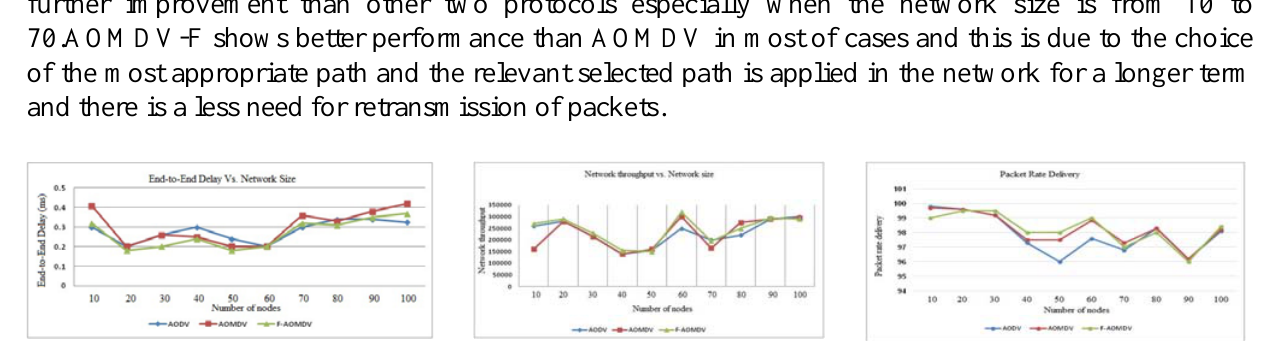
Fig. 5. Performance assessment Vs end to end delay